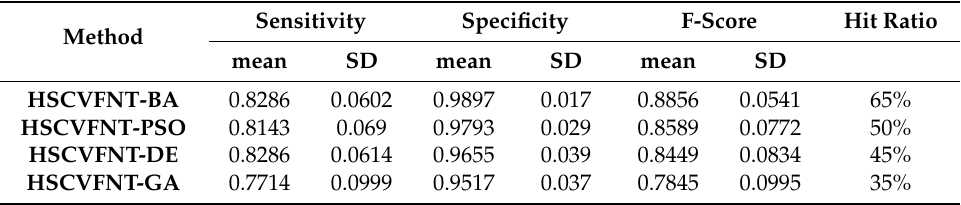
Table 4. Comparison of four methods for SOS network inference.